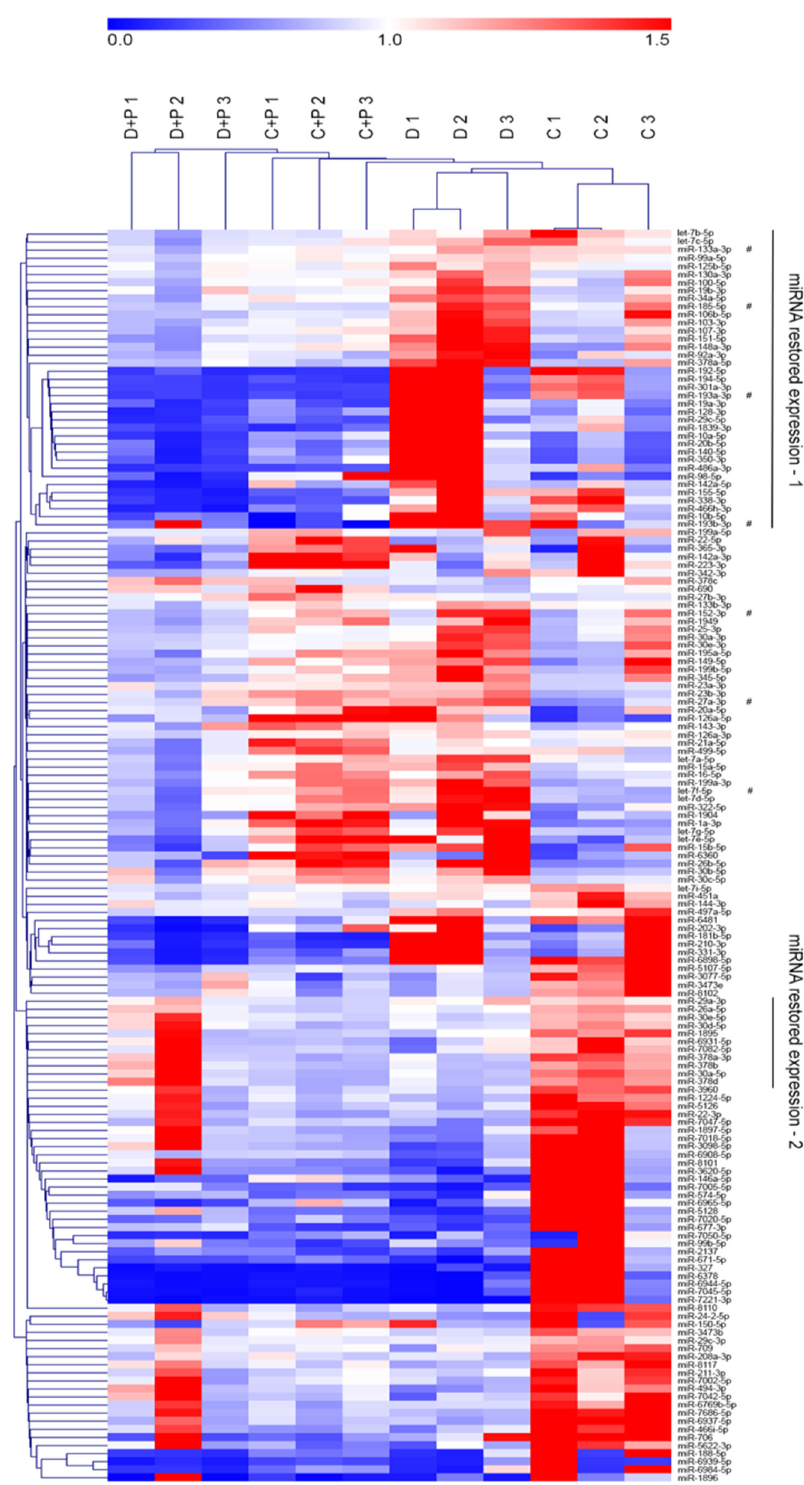
Figure 3. MiRNA gene expression. Heatmap of differentially expressed miRNAs. Both samples and miRNAs were clustered according to average dot products and complete linkage. Cluster 1 represents miRNAs upregulated in heart samples of diabetic mice that returned to control levels after pargyline treatment. Cluster 2 represents miRNAs downregulated in heart samples of diabetic mice that were normalized after pargyline treatment. C: control; C + P: control + pargyline; D: diabetes; D + P: diabetes + pargyline.